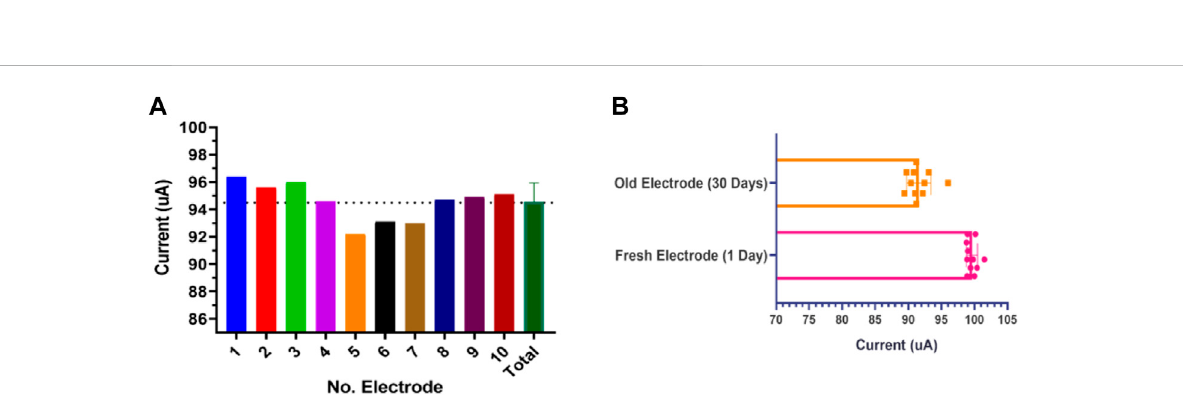
FIGURE 9 (A) Fabrication repeatability was examined for ten different SPEs based current response. (B) Response current stability for ten SPEs in 0.5 mM